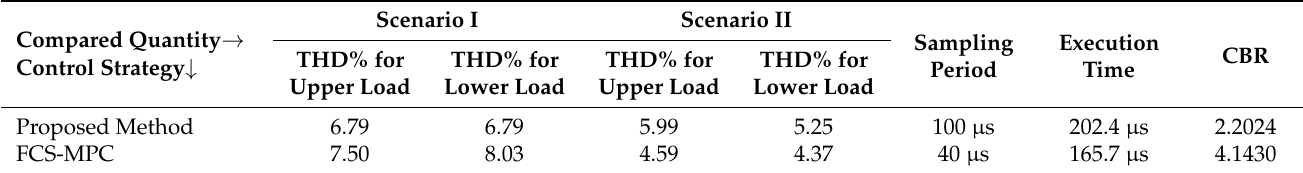
Table 4. Comparison results in terms of the computational burden.